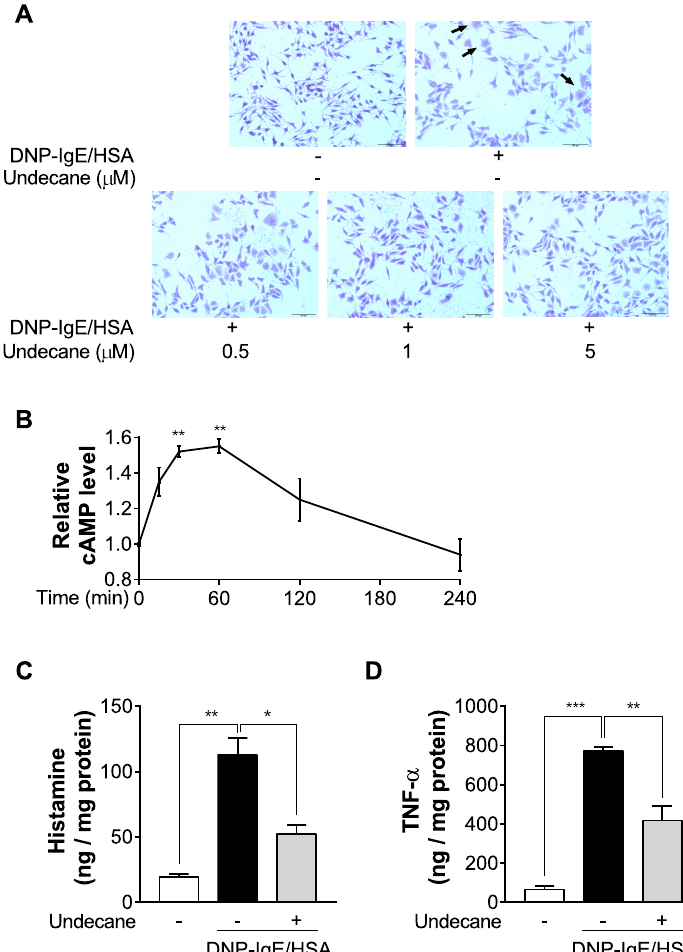
Figure 2. E ff ect of undecane on degranulation in dinitrophenyl immunoglobulin E / human serum albumin (DNP-IgE / HAS) stimulated RBL-2H3 cells. RBL-2H3 cells were pretreated with gradient concentrations of undecane (0.5, 1 and 5 µ M) for 1 h and stimulated with DNP-IgE / HSA (50 ng / mL each) for 5 h. After that, ( A ) the images of toluidine blue-stained cells were captured. Arrows show that the cell morphology was irregular and unclear. Purple granules were secreted outside the cells. The scale bar represents 100 μm. ( B ) RBL-2H3 cells were incubated with undecane (1 μM) for various times and the effect of undecane on intracellular cAMP levels was determined. RBL-2H3 cells were preincubated with undecane for 1 h and stimulated with DNP-IgE/HSA (50 ng/mL each) for 5 h. ( C ) The histamine and ( D ) tumor necrosis factor α (TNF-α) concentrations were then measured in the supernatants. The final concentrations were normalized to the total cellular protein amount. The data were expressed as the mean ± SEM ( n = 3). Significant di ff erences between groups are indicated by asterisks; * p < 0.05; ** p < 0.01; *** p <